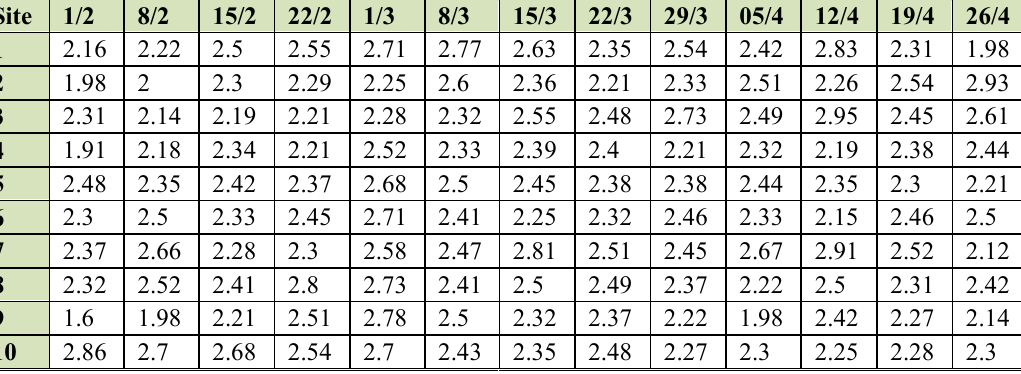
Table 4: Dissolved oxygen values (ppm).